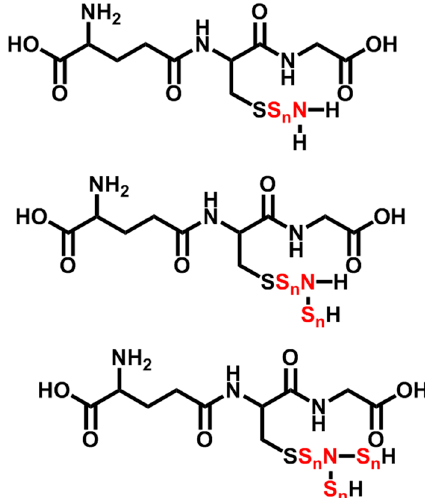
Scheme 4. Structural isomers of trithionitrates.